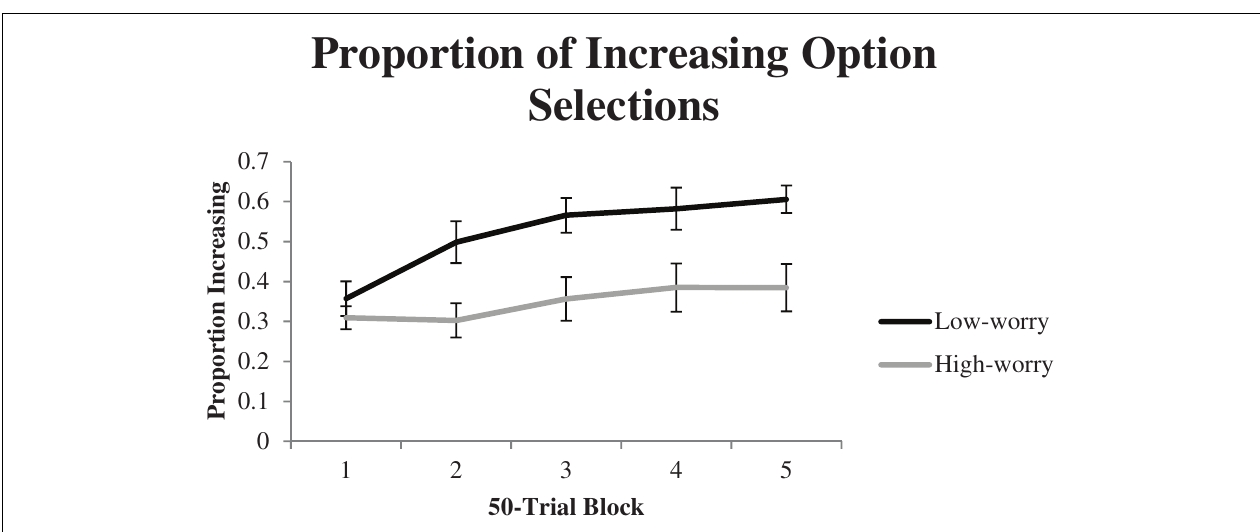
FIGURE 3 | Average proportion of increasing option selection for each group during each 50-trial block of Experiment 1. Error bars represent standard errors of the